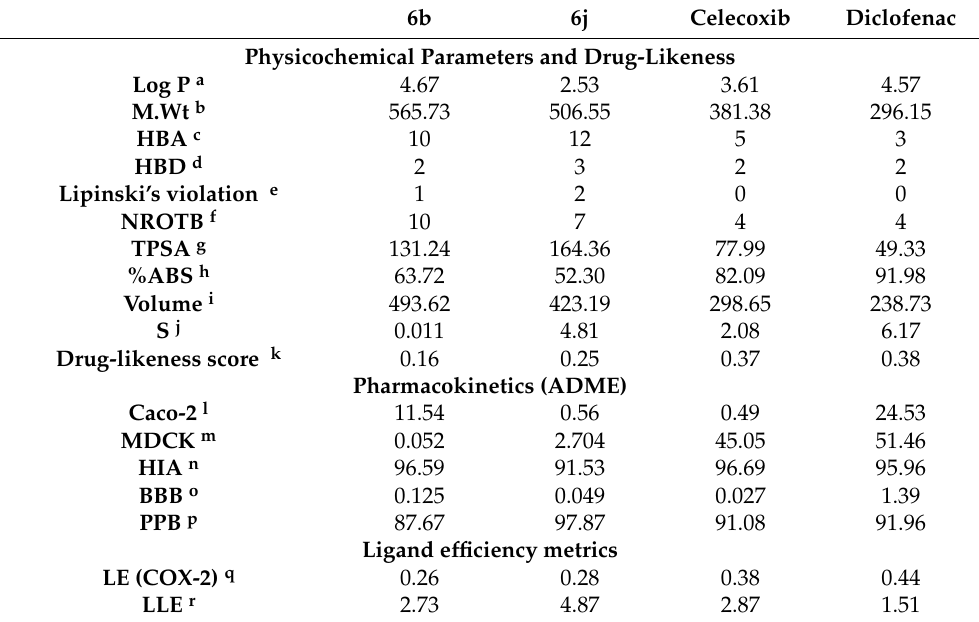
Table 4. In silico prediction of the physicochemical properties, drug-likeness, pharmacokinetics and ligand efficiency metrics of compounds 6b and 6j